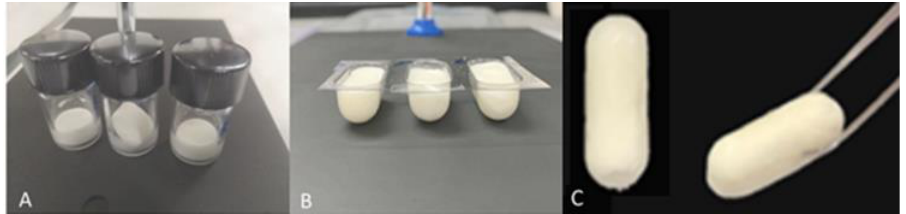
Figure 6. Aspect of lyophilized cakes inside vials ( A ), inside blisters ( B ) and after withdrawal from blister ( C ).